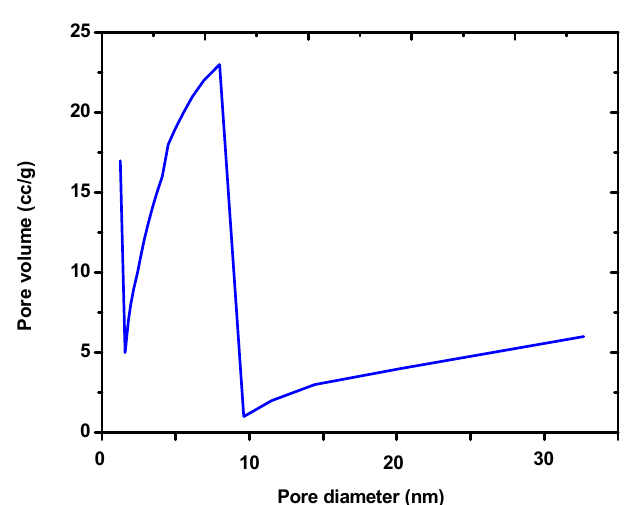
Fig. 9. BET plots of CoFe Figure 9 .BET plots of CoFe 2 O 4 @SiO 2 nanoparticles.